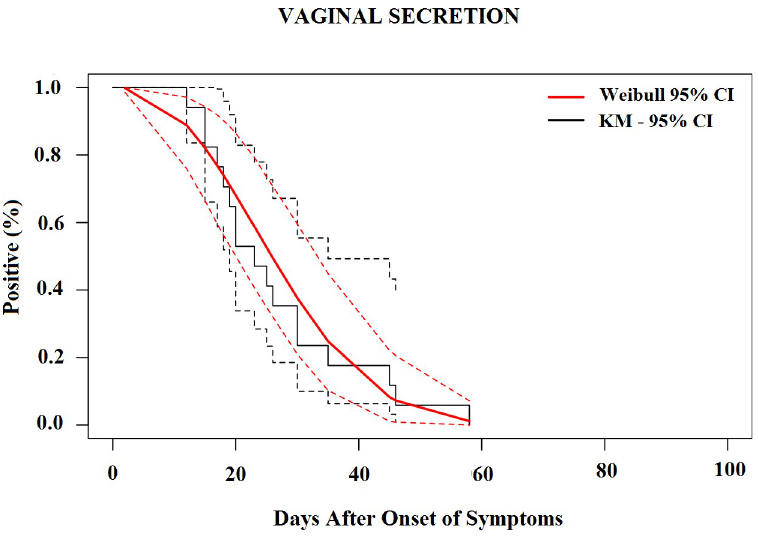
Fig 5. Survival curves (Kaplan–Meier analysis) of CHIKV RNA persistence in Vaginal Secretion, with Weibull fit.